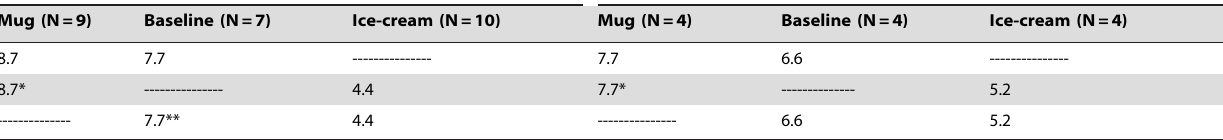
Pairwise Comparison between